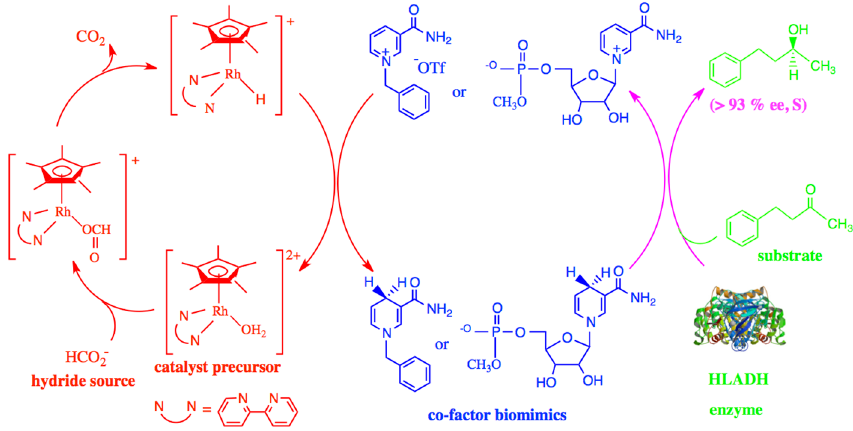
Figure 1. Biomimetic NAD + co-factors, N-1-benzylnicotinamide triflate, 1 , and β -nicotinamide-5'-ribose methylphosphate, 2 , for regeneration of their 1,4-NADH derivatives, N-1-benzyl-1,4-dihydronicotinamide, 3 , and β -1,4-dihydronicotinamide-5'-ribose methylphosphate, 4 , with in situ formed [Cp*Rh(bpy)H](OTf), and in tandem with the HLADH biocatalysis reactions, to provide a chiral alcohol from a achiral ketone.